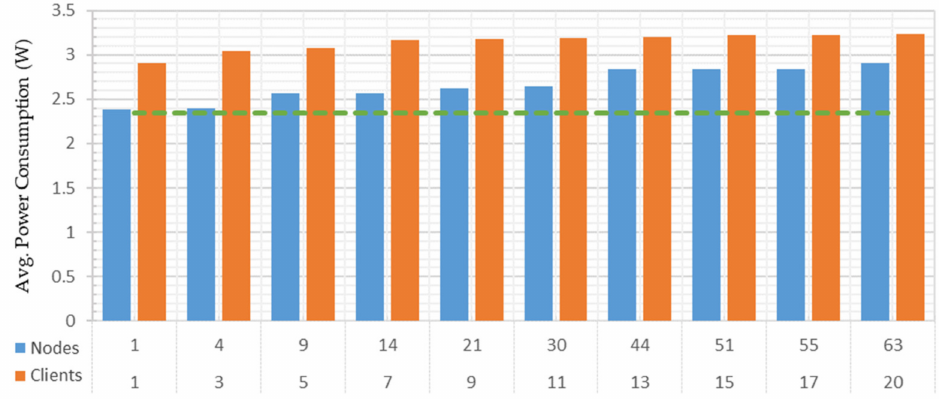
Figure 19. Average Pi power consumption with varying the OPC UA server nodes and clients. The green dashed line in Figure 19 represents the Pi’s base power consumption. The blue bar represents the first test case, which showed an average of 2.3871 watts of power a single OPC UA client utilized an average of 2.9044 watts of power. Hence, 0.5588 watts